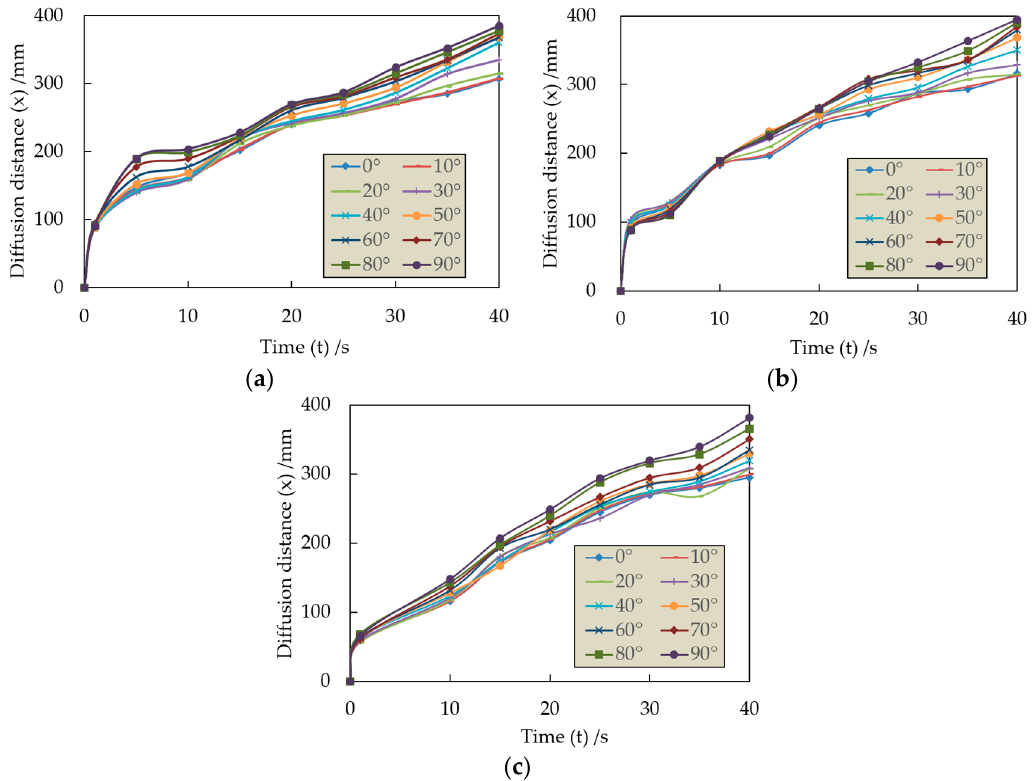
Figure 15. Diffusion distance in all directions under different test conditions. ( a ) R1; ( b ) R2; ( c ) R3.